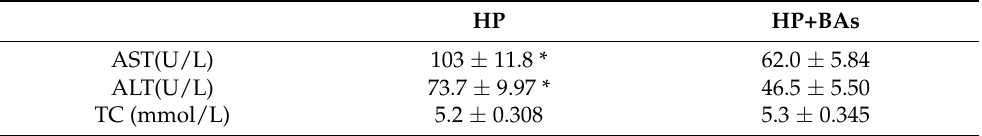
Table 3. Plasma biochemical parameters. The concentrations of AST and ALT in the HP+BAs group was significantly lower than in the HP group. * Data are shown as mean ± SEM ( n = 7). Statistically significant results are indicated by asterisks (*, p < 0.05).